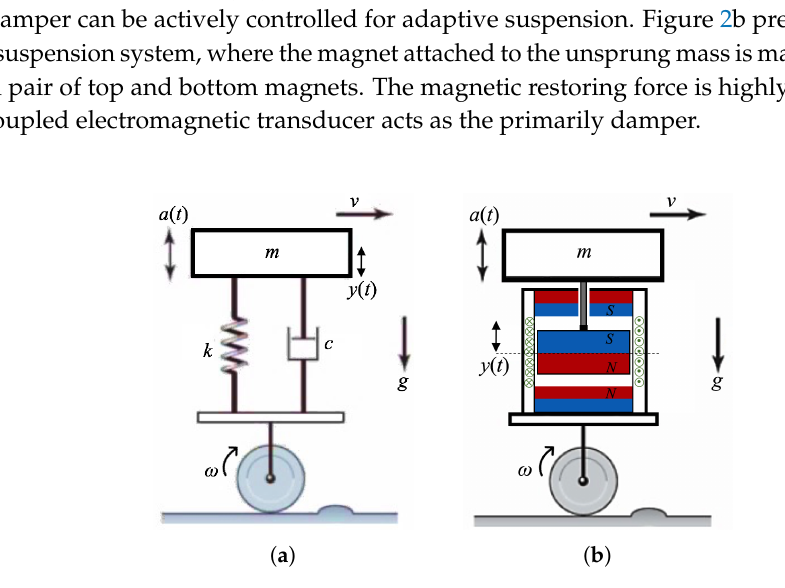
Figure 2. Quarter model of the car suspension. The sprung models of the inflated wheel and the seat are not shown here. The control system is also not shown here, which either varies the damping ratio of conventional springs or the electromagnetic coupling of the magnetic suspension. ( a ) Mechanical spring suspension; ( b ) magnetic spring